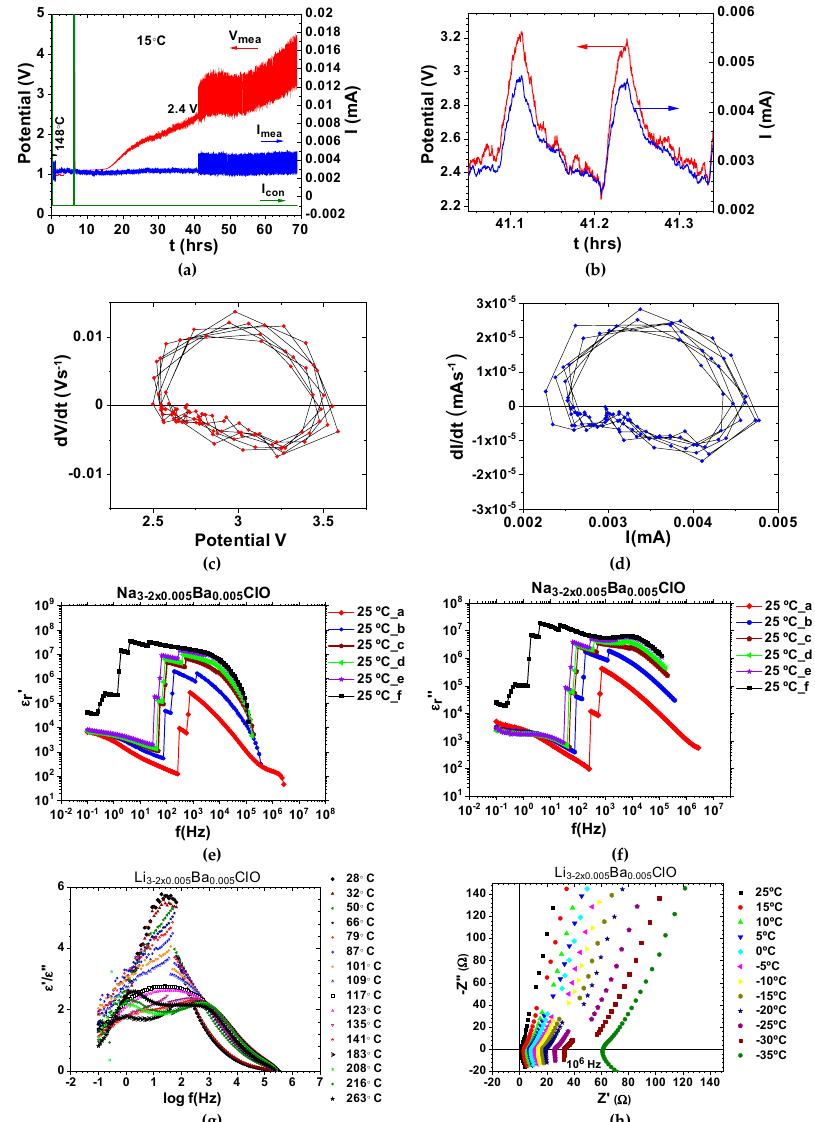
Figure 4. conductor 1 /ferroelectric-electrolyte/conductor 2 cells showing self-charging and self-cycling while set to discharge and amplitude jumps (discontinuities) related frequency response in a Duffing oscillator as shown in Figure 1g; ( a ) self- charge and self-oscillations observed with an Al/90 wt. % Li-glass (Li 2.99 Ba 0.005 ClO) + 10 wt. % Li 2 S/Cu cell while set to discharge at a constant current of − 1 µA (adapted from [70]); ( b ) inset of a) showing small oscillations like n in Figure 2f and w (current) in Figure 2g; ( c ) and ( d ) phase portraits of the voltage and current oscillations shown in ( a,b )which clearly show limit cycles; ( e ) and ( f ) relative real and imaginary permittivities for Na 2.99 Ba 0.005 ClO for different times at 25 ° C showing jumps in the amplitude of the forced oscillations imposed by the electrical impedance spectroscopy (EIS) meas- urement (adapted from [66]); ( g ) relative real and imaginary permittivities ratio for Li 2.99 Ba 0.005 ClO, at different tempera- tures, showing jumps in the amplitude of the forced oscillations imposed by the electrical impedance spectroscopy (EIS) measurement driving forces; ( h ) imaginary vs real impedances for Li 2.99 Ba 0.005 ClO, at different temperatures, showing jumps in the amplitude of the forced oscillations imposed by the electrical impedance spectroscopy (EIS) (adapted from [64]). Note: EIS is an AC technique, therefore, a frequency response as shown in Figure 1g for a Duffing oscillator is ex- pected. The voltage amplitude was 10 mV.